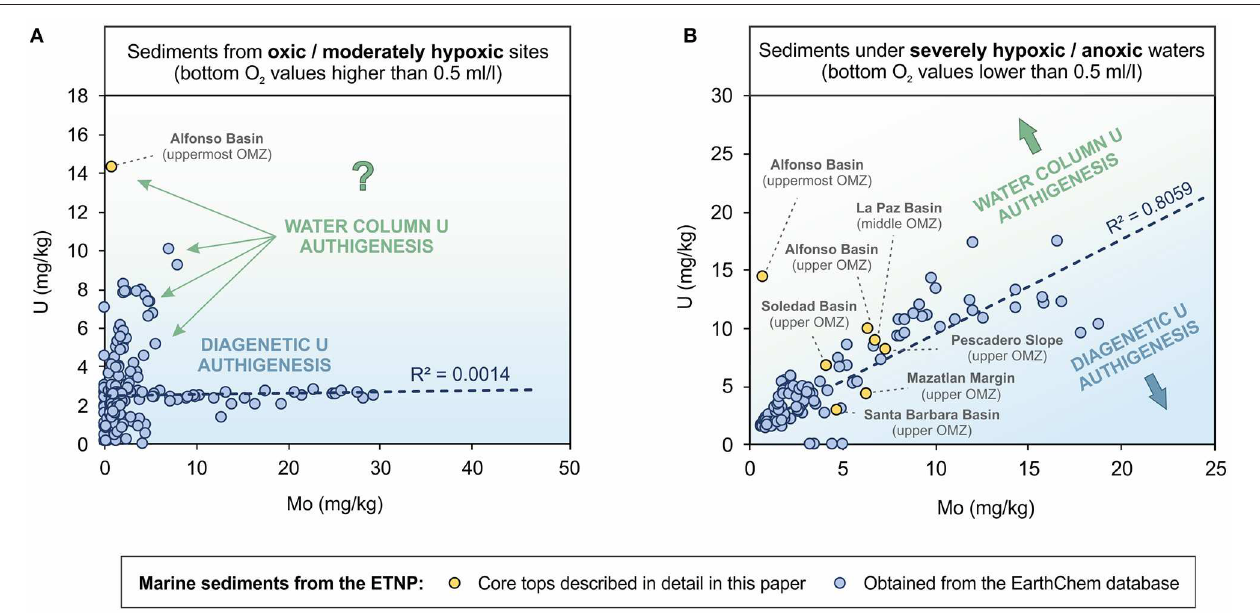
FIGURE 7 | Correlation between U and Mo in sediments collected under (A) oxic or moderately hypoxic waters and (B) severely hypoxic or anoxic waters from different basins of the Eastern Tropical North Pacific (Data from: this study; Ivanochko and Pedersen, 2004; McManus et al., 2006; Choumiline et al., 2017; EarthChem database with n =